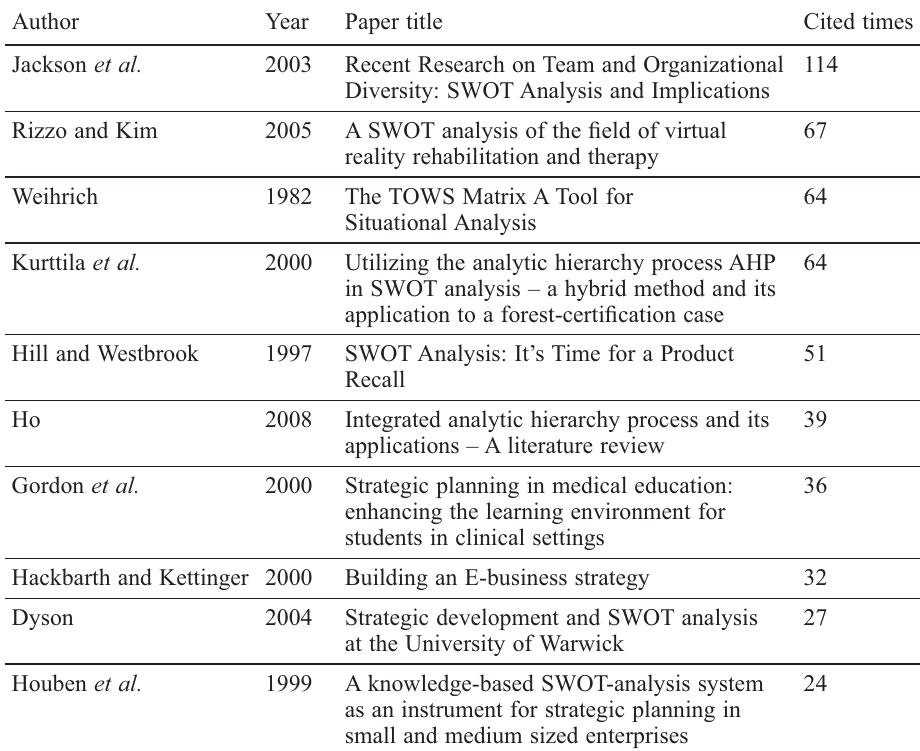
Table 5. Top 10 cited papers on SWOT until July, 1th, 2010 in